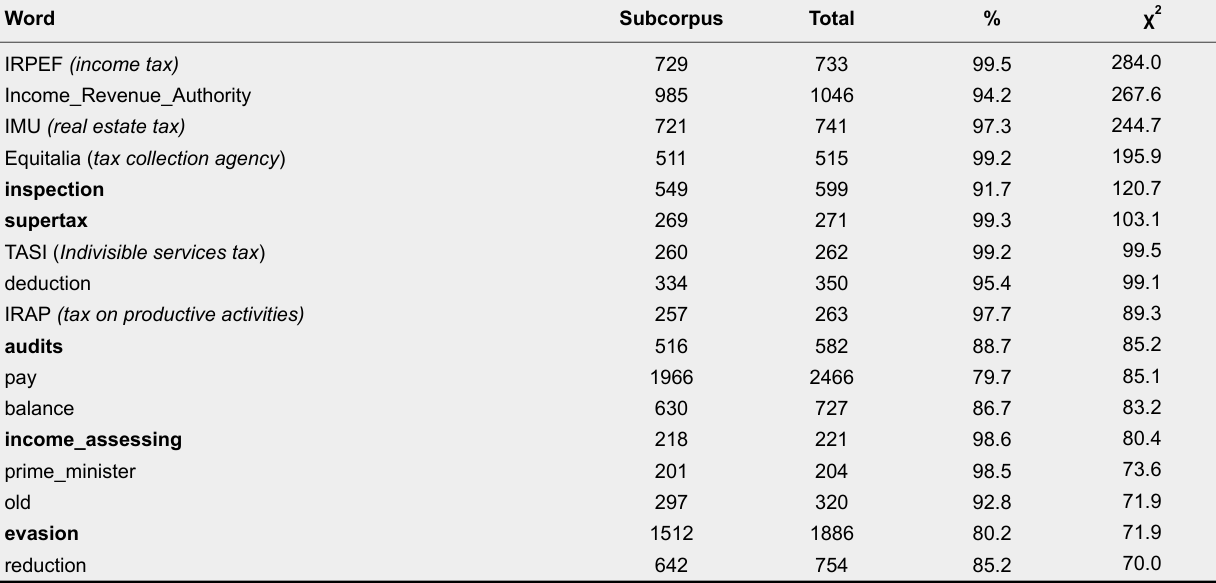
Specificity Analysis: Overused Words in